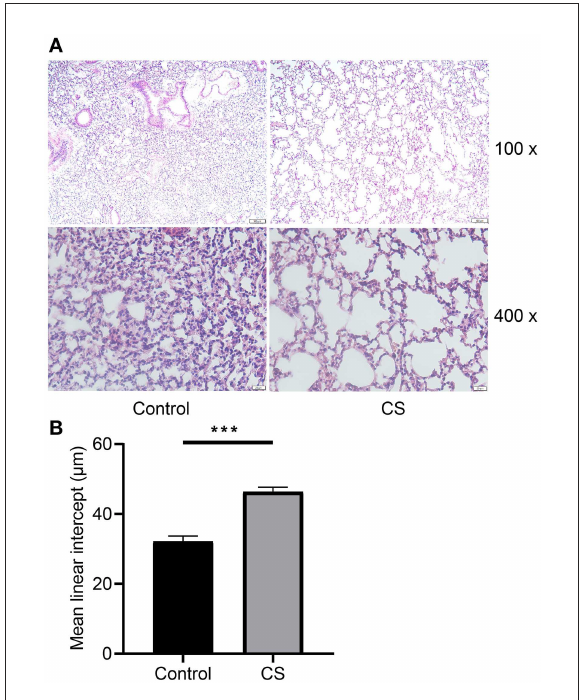
FIGURE2 Histopathological analysis and morphometry of mouse lung tissues from cigarette smoke treatment group and control group. (A) Hematoxylin–eosin staining of mouse lung tissues from two groups. (B) Mean linear intercept of mice from two groups. *** p <